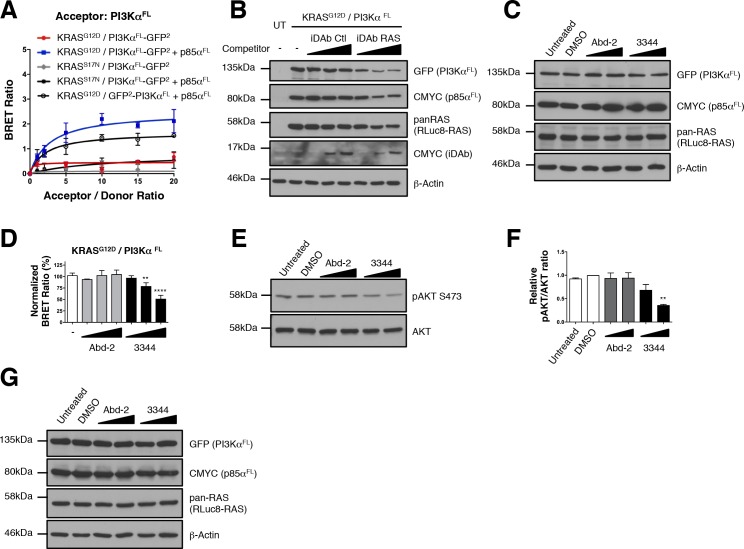
Interaction of KRASG12D with PI3KαFL is inhibited by 3344.(A) BRET titration curves of KRASG12D and KRASS17N mutants with full-length PI3Kα (PI3KαFL). KRASG12D interacts with PI3KaFL when the full-length regulatory subunit p85a is co-expressed along with the BRET pair but not KRASS17N. The optimal BRET signal is obtained with the following pair: RLuc8-KRASG12D/PI3KαFL-GFP2. (B) Controls from Figure 4B. The expression level of the BRET pair was assessed with the GFP (for PI3KαFL) and pan-RAS (for RLuc8-KRASG12D) antibodies. iDAb and p85αFL expression was revealed by the CMYC tag antibody, β-actin was used as the loading control. (C) Controls from Figure 4E. The expression level of the BRET pair was assessed with the GFP (PI3KαFL) and pan-RAS (RLuc8-KRASG12D) and CMYC (p85αFL) antibodies. Anti-β-actin was used as the loading control. In panel D, HEK293T cells transfected with the BRET biosensor KRASG12D/PI3KαFL were treated for 3 hr with DMSO (white bar), 5, 10 and 20 μM of Abd-2 (grey bars) and 3344 (black bars) compounds and the BRET signal of the biosensor was assessed. In panel E, the cells were transfected and treated as in panel D but with 10 and 20 μM of Abd-2 and 3344 compounds. 3 hr after the treatment, cells were lysed and analyzed by western blot using anti-pAKT (Ser 473) or anti-pan-AKT antibody. The signal in the western blot is quantitated in panel F. (G) Controls from panel E. One-way ANOVA followed by Dunnett’s post-hoc tests were used to determine the statistical significance of BRET and pAKT modulations induced by the compounds (**p<0.01, ****p<0.0001). Each experiment was repeated twice (A, E–F) or three times (D). Where error bars are presented, they correspond to mean values ± SD of biological repeats (A, D) or correspond to mean ± SEM of biological repeats (F).